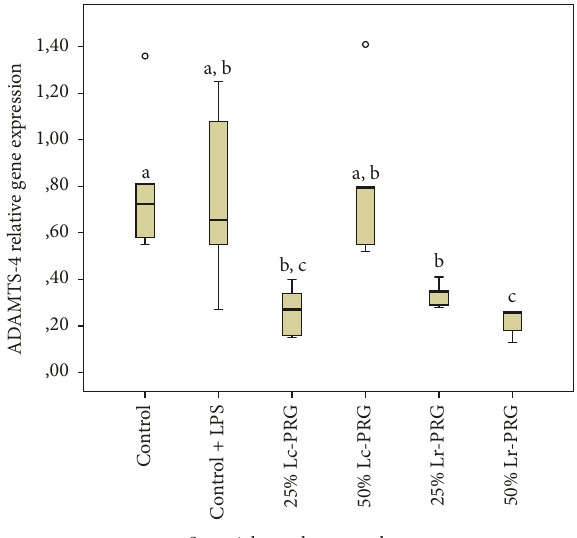
Figure 4: Box plot of median relative a disintegrin and metal- loproteinase with thrombospondin motifs 4 (ADAMTS-4) gene expression. a–c Lowercase letters denote significant differences (𝑝 > 0.05) between SME groups treated with Lc-PRG and Lr-PRG supernatants at different concentrations (25 and 50%). Groups with the same lowercase letter are not significantly different. ∘ denotes an outlier value, showing nonparametric data.